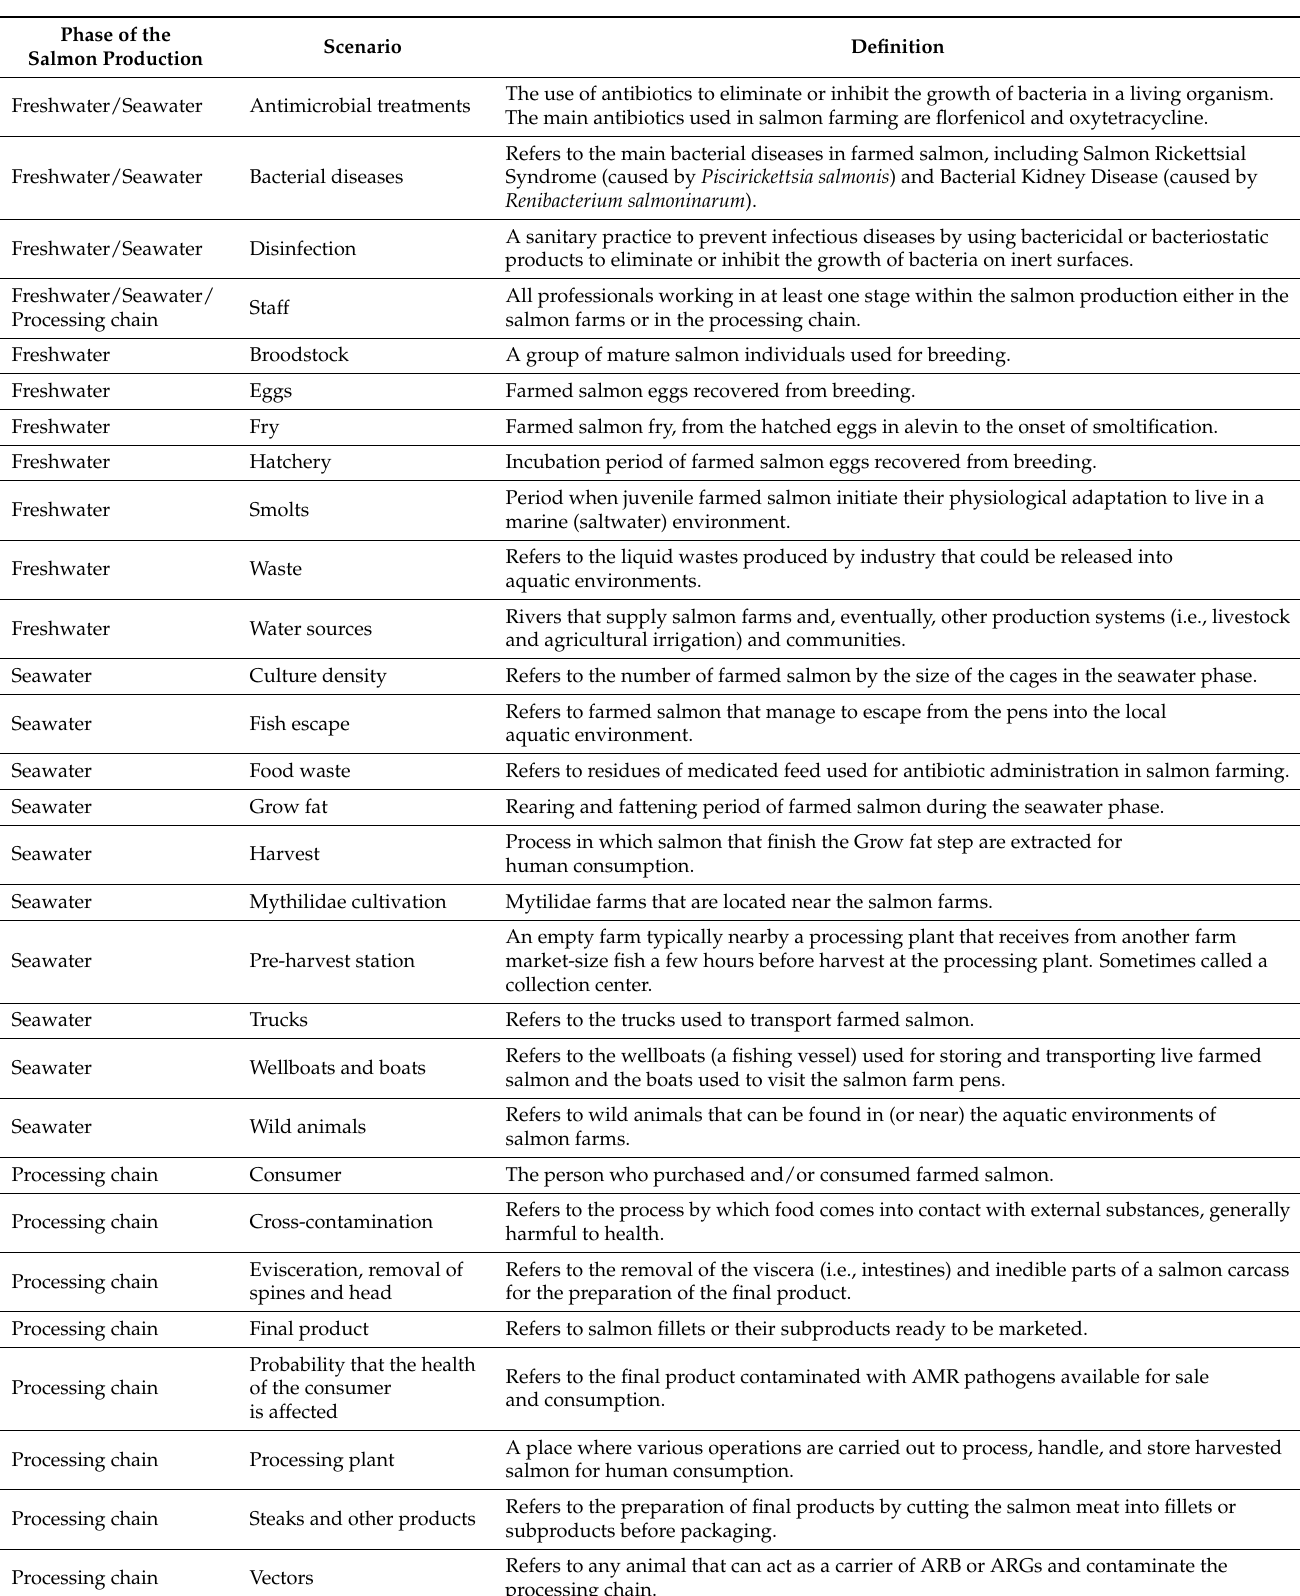
Table 4. Brief description of the main scenarios within the salmon production